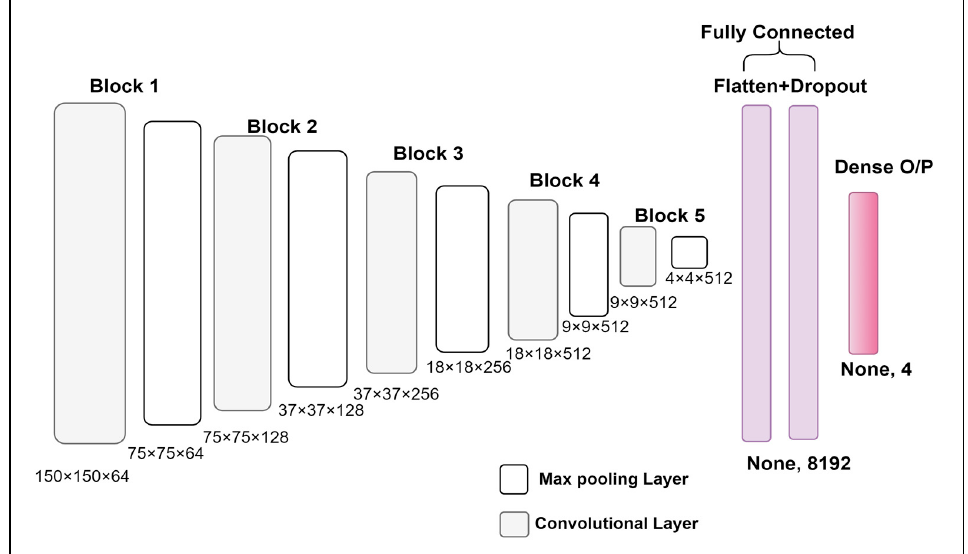
Figure 3. Detailed